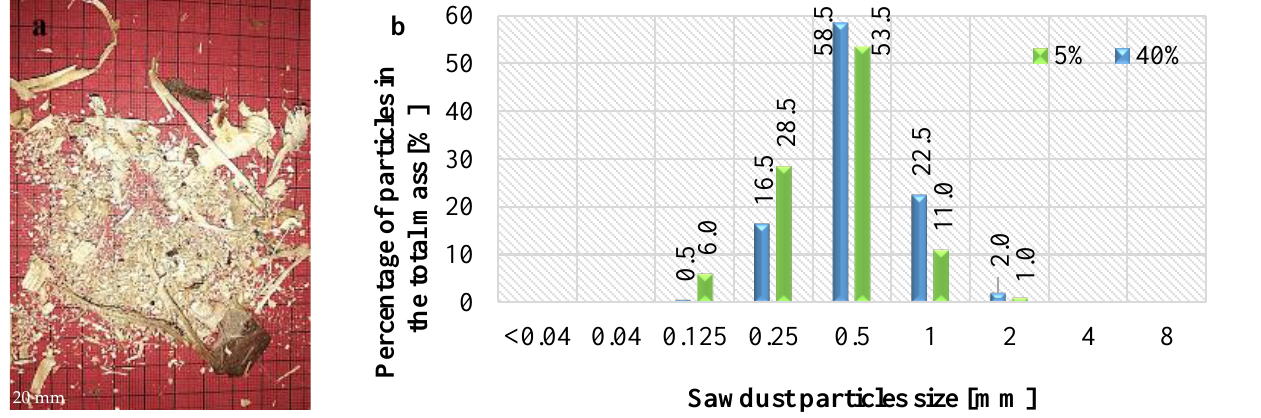
Figure 3. ( a ) Mixture of a pine sawdust collected in this work. ( b ) Histogram of the sawdust size distribution with the humidity of 5% and 40%, respectively.